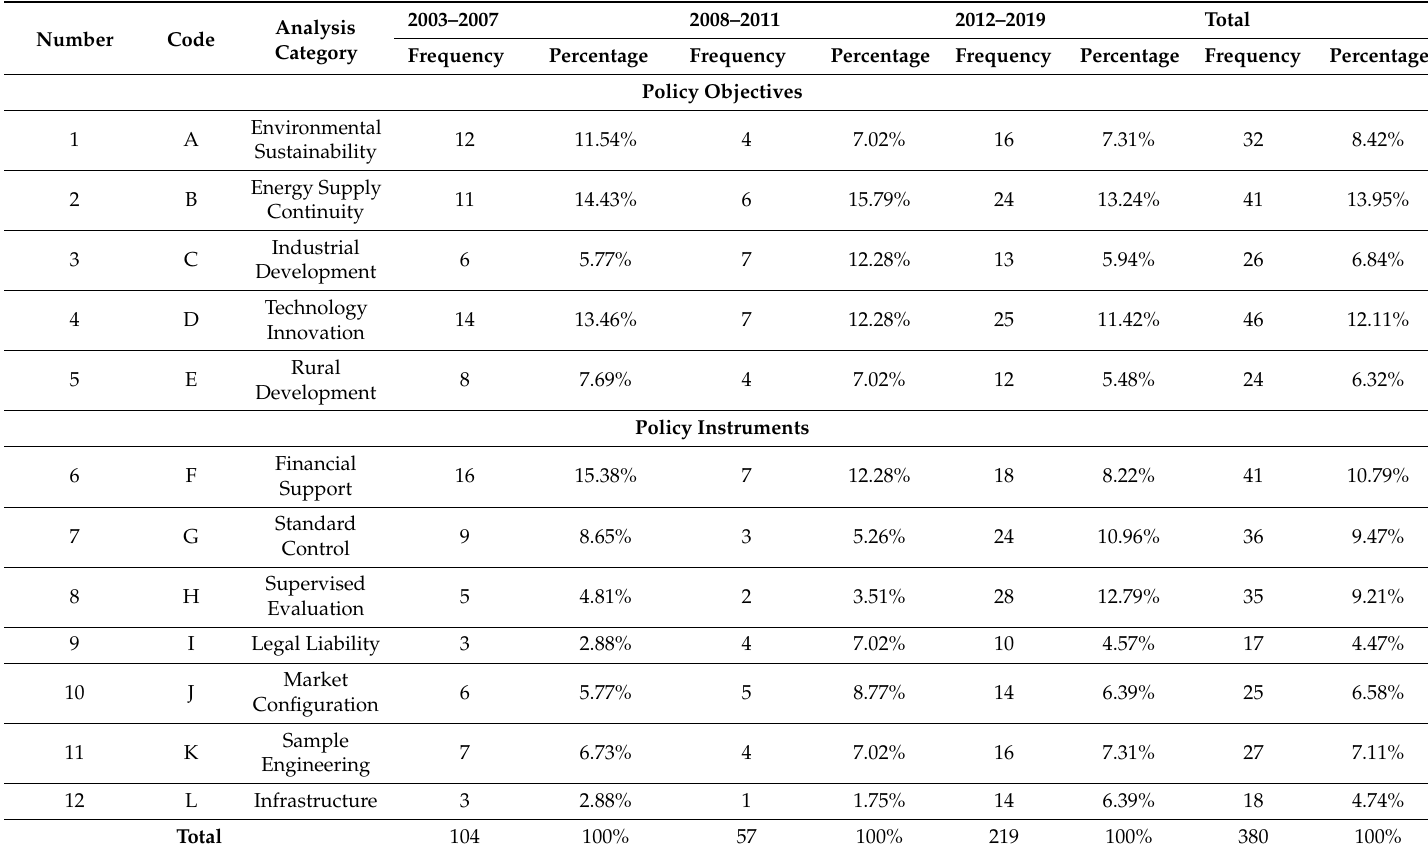
Table 3. Codes and Frequency of each analysis